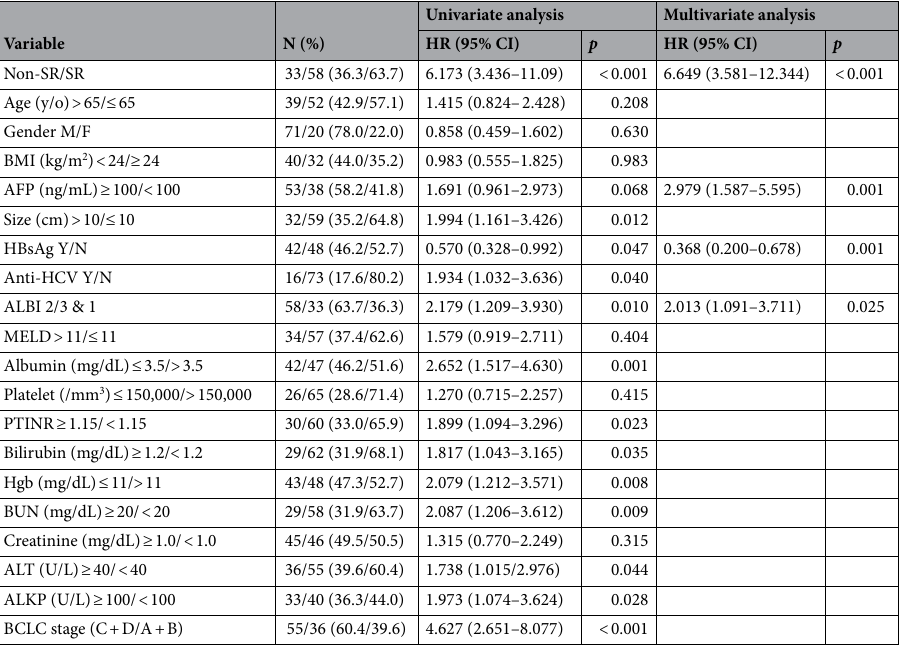
Table 2. Factors associated with poor OS in HCC patients with tumor rupture in univariate and model I multivariate analysis. CI confidence interval, SR surgical resection, BMI body mass index, AFP α-fetoprotein, HBsAg hepatitis B surface antigen, HCV hepatitis C virus, MELD model for end-stage liver disease, ALBI albumin-bilirubin, PT INR prothrombin time/international normalized ratio, HgB hemoglobulin, ALT